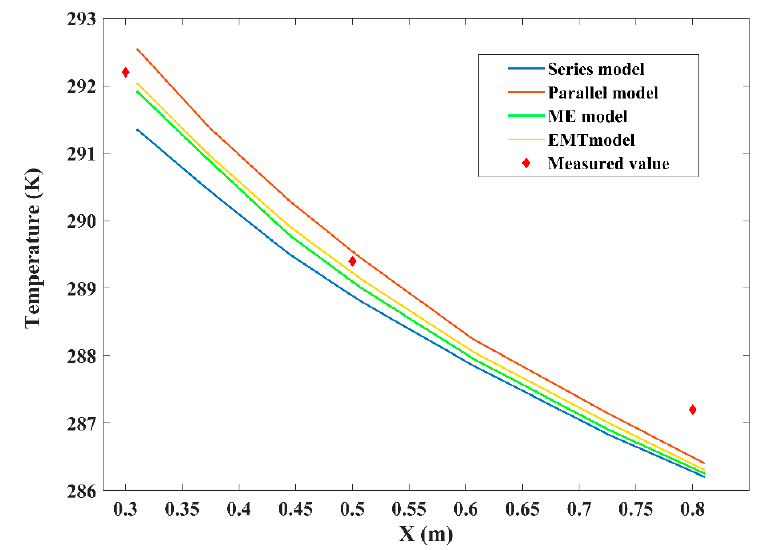
Figure 6. Temperature distribution from point C to E.